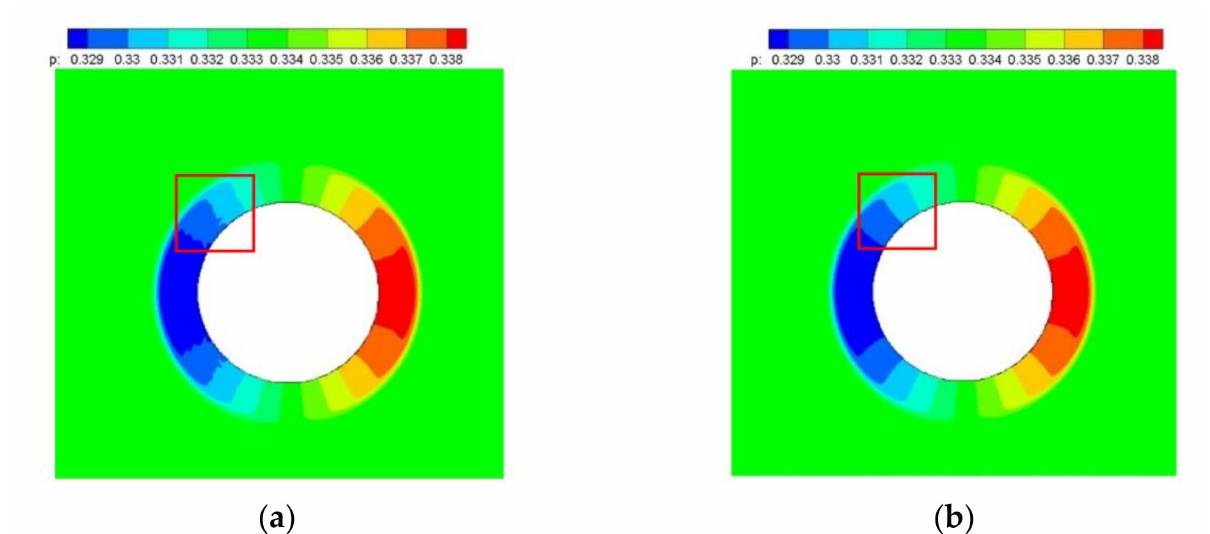
Figure 2. Pressure field distribution before and after boundary correction; ( a ) before boundary correction; ( b ) after boundary correction.